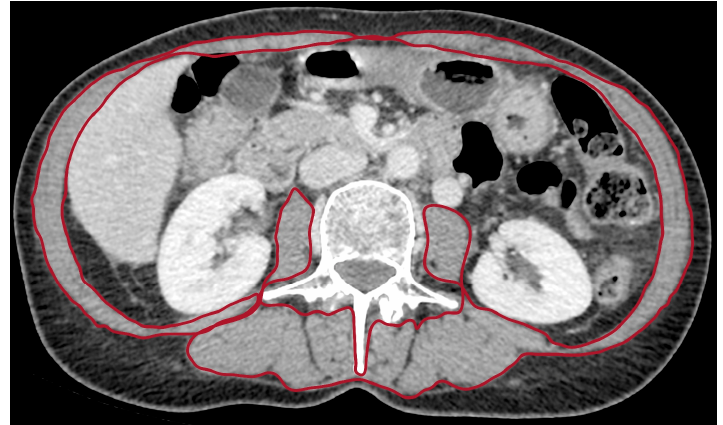
Figure 1. CT image in the axial plane at the level of the third lumbar vertebra in a sarcopenic patient with metastatic pancreatic carcinoma. Regions of interest (ROI) for sarcopenia measurements on axial CT image are indicated inside the red zone.